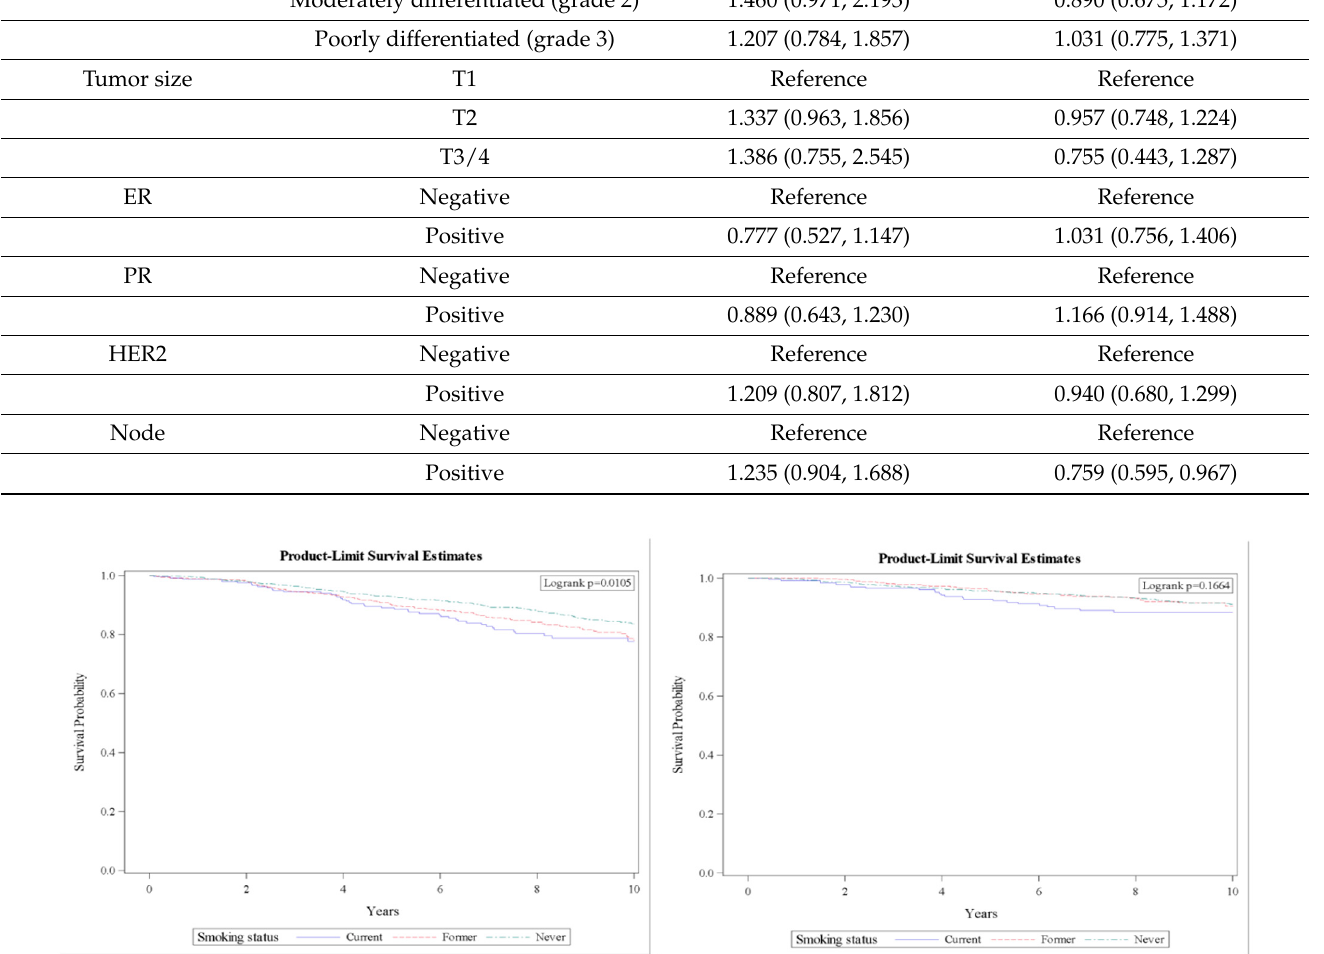
Figure 1. 10-year survival curves for overall ( left ) and breast cancer specific survival ( right ). Con- trolled for age, race, BMI, CCI, marital status, education, treatment site, stage, tumor characteristics (grade, type, size), node status, and hormone receptor (HER2, ER, and